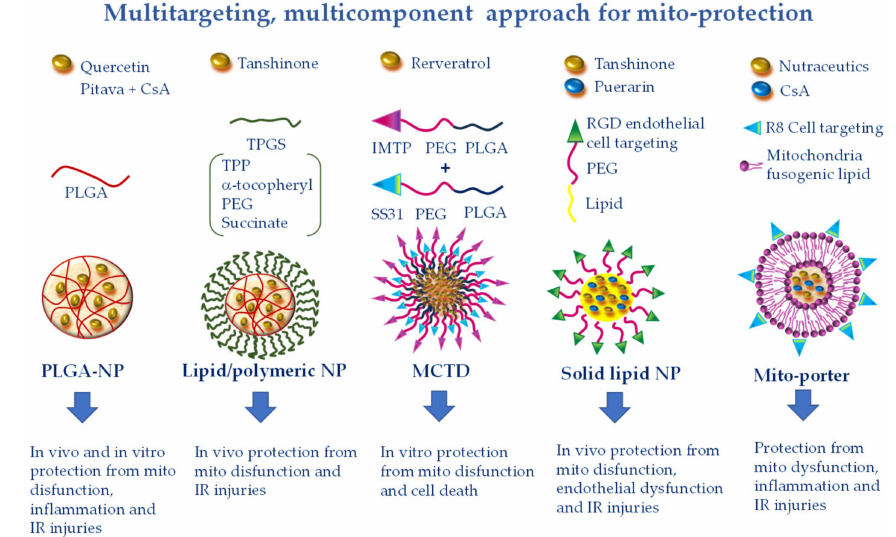
Figure 5. Multitargeting, multicomponent approaches for mito-protection exploiting the pleiotropic e ff ects of several nutraceutics or the combination of more protective compounds with di ff erent mechanisms of action. NPs can be functionalized to achieve optimal targeting of specific tissue districts and cell types. Polyethylene glycol (PEG) and poly(lactic-co-glycolic) acid (PLGA) accumulate NPs at the injury site because of the enhanced permeability and retention e ff ect. The ischemic myocardium-targeting peptide (IMPT) ensures vehiculation at the IR zone. The cell-targeting peptides RGD and R8 drive cell uptake. Finally, triphenilphosphonium (TPP), Szeto–Schiller 31 (SS31), and mitochondria fusogenic lipid moieties elicit greater mitochondrial